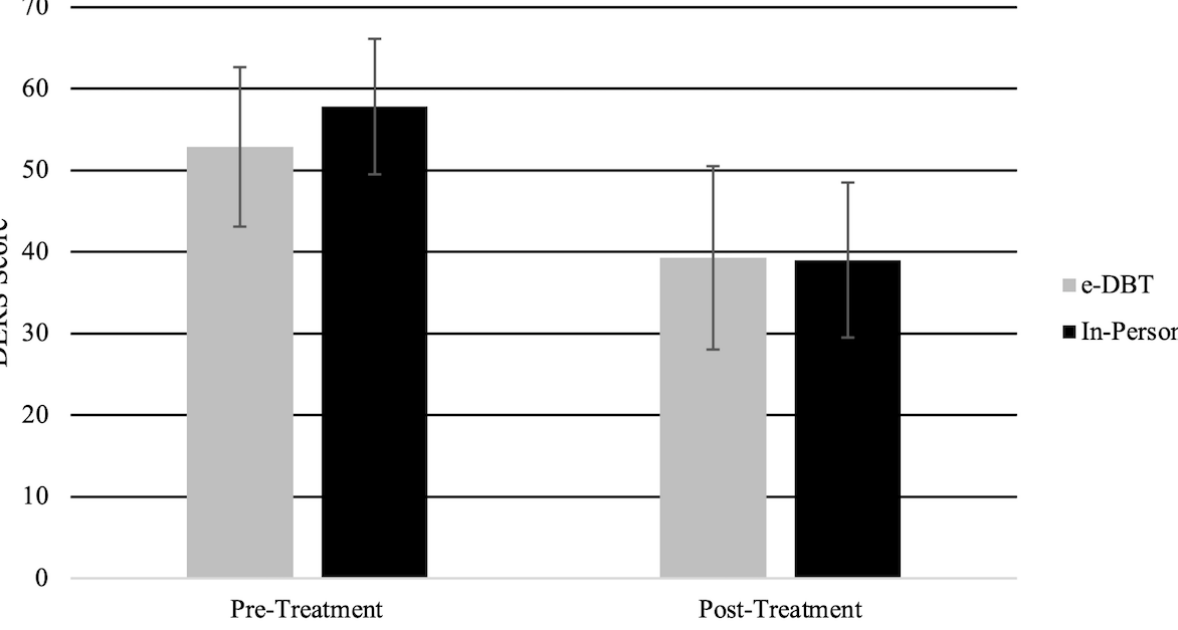
Figure 4. Difficulties in Emotion Regulation Scale (DERS) scores at baseline and 15 weeks. e-DBT: electronically delivered dialectical behavioral